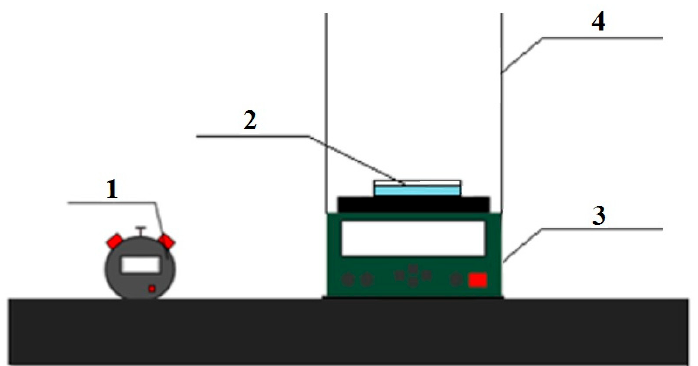
Figure 2. Diagram of a stand used to test the evaporation rate. ( 1 ) stopper, ( 2 ) tested substance set on Petri dish with a diameter of 9 cm, ( 3 ) analytical scales, ( 4 ) side screen to reduce the impact of air movements.